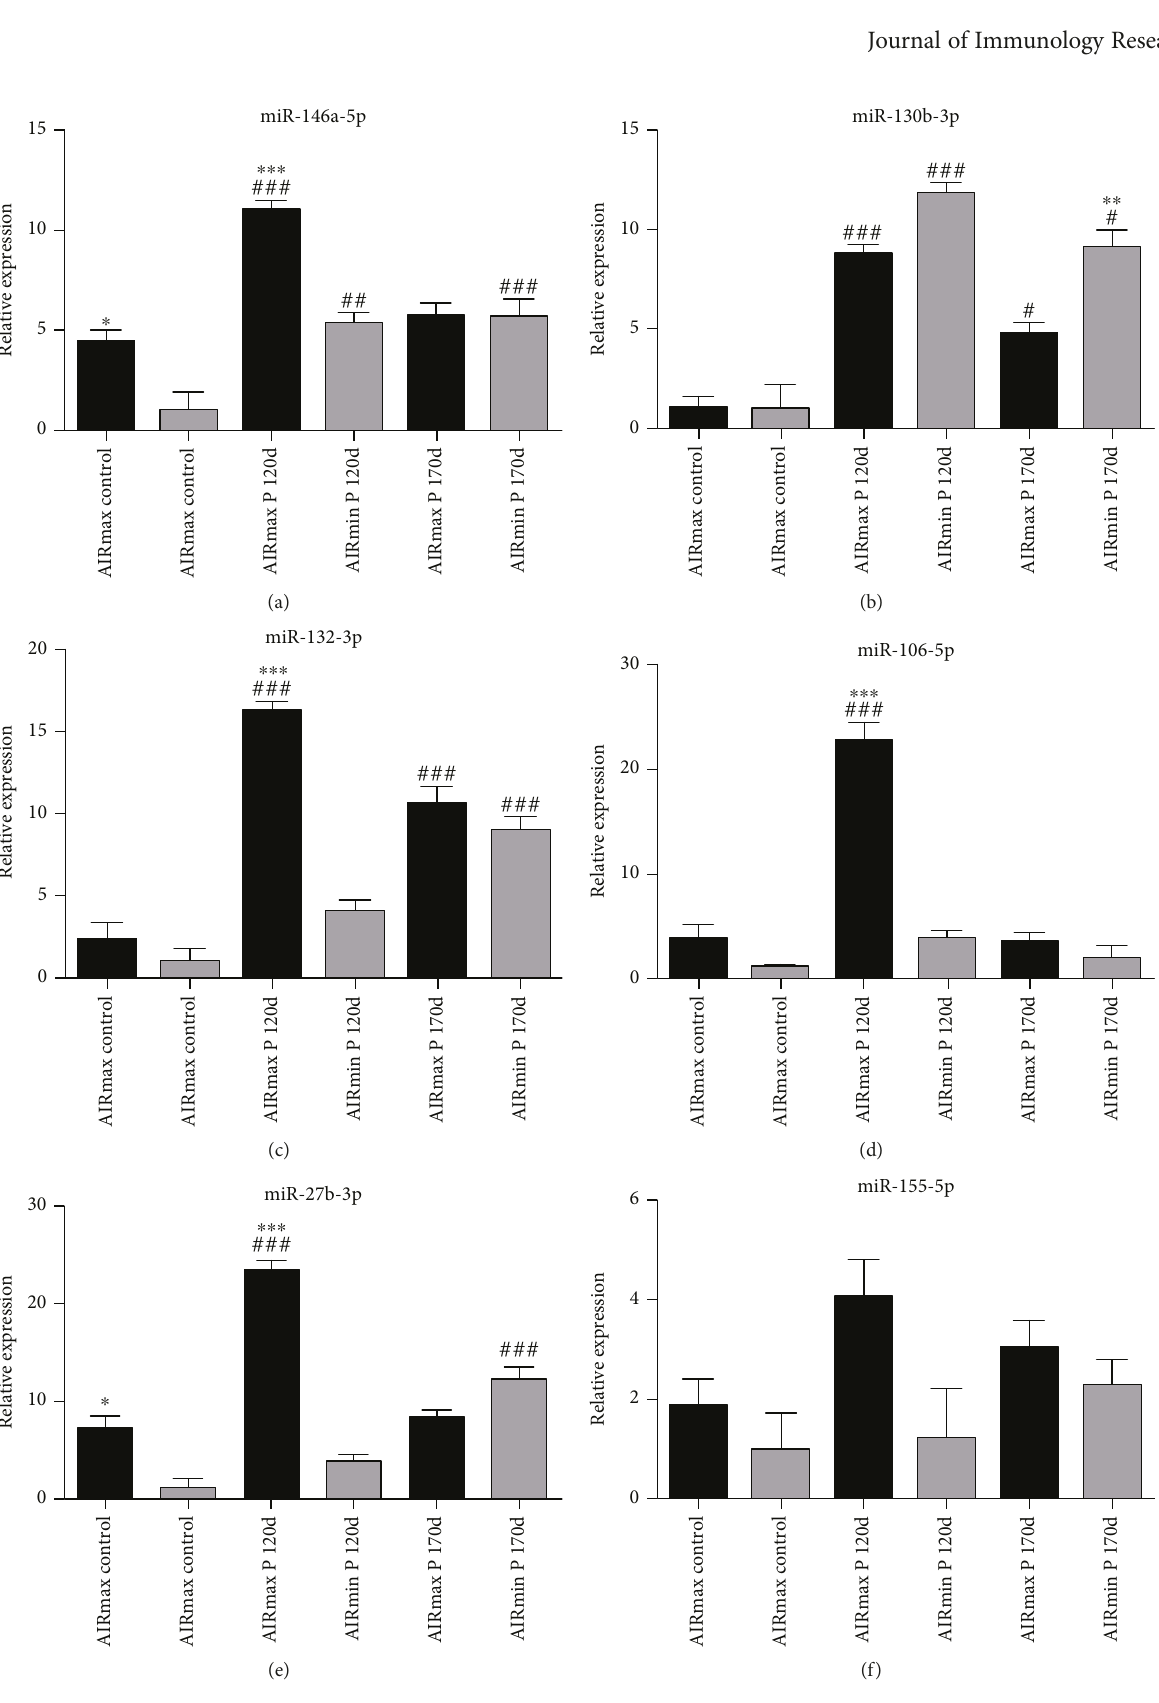
Figure 6: Relative gene expression determined by qRT-PCR in peritoneal cells of AIRmax and AIRmin mice 120 and 170 days after pristane injection ( n = 5 mice/group). Data expressed as mean ± standard error of two independent experiments; statistical analysis by ANOVA followed by Tukey ’ s post hoc tests. ∗ p < 0 05 between AIRmax and AIRmin; # p < 0 05 between control and pristane-injected